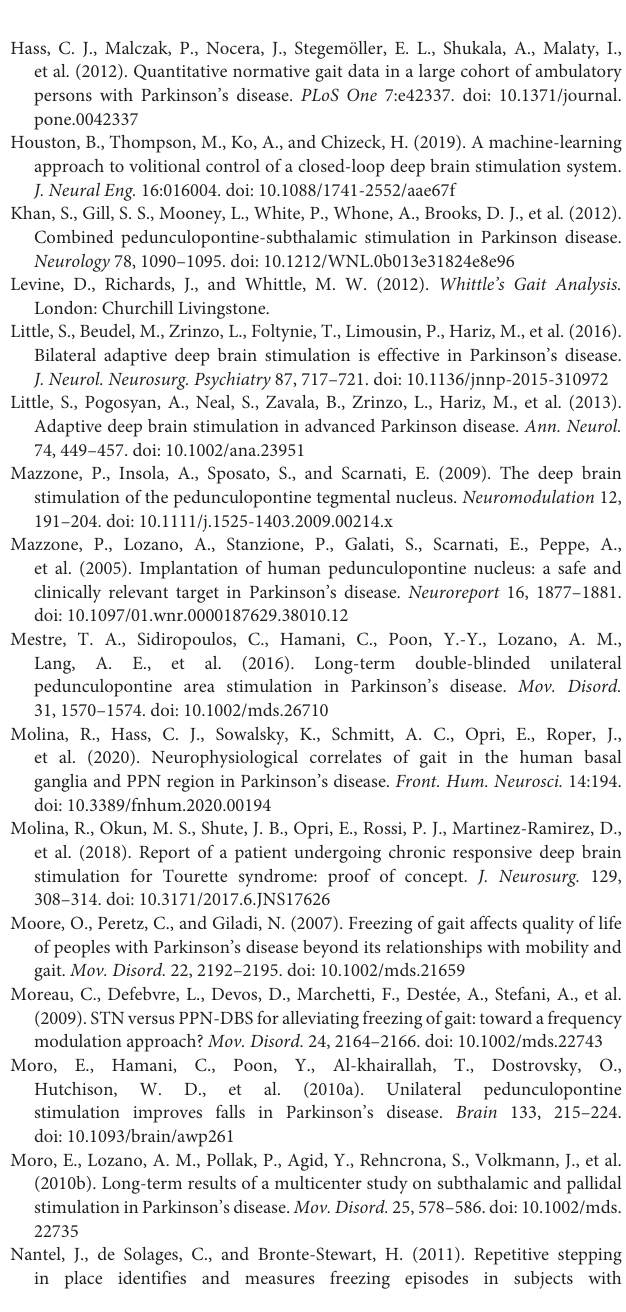
SUPPLEMENTARY TABLE 1 | Lead locations of the active contacts. SUPPLEMENTARY TABLE 2 | Stimulation protocol at each